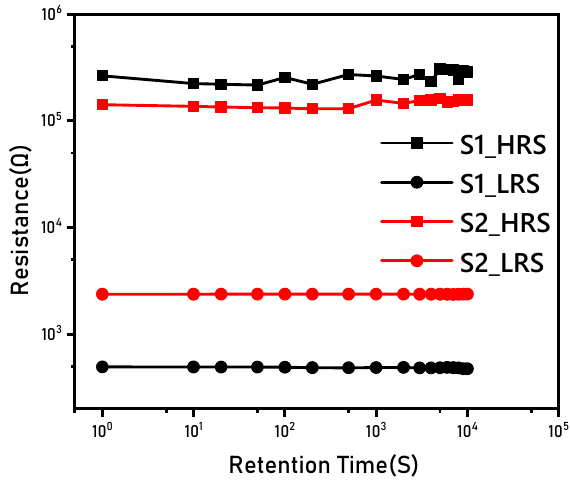
Figure 5. Data retention time of S1 and S2 RRAM devices.